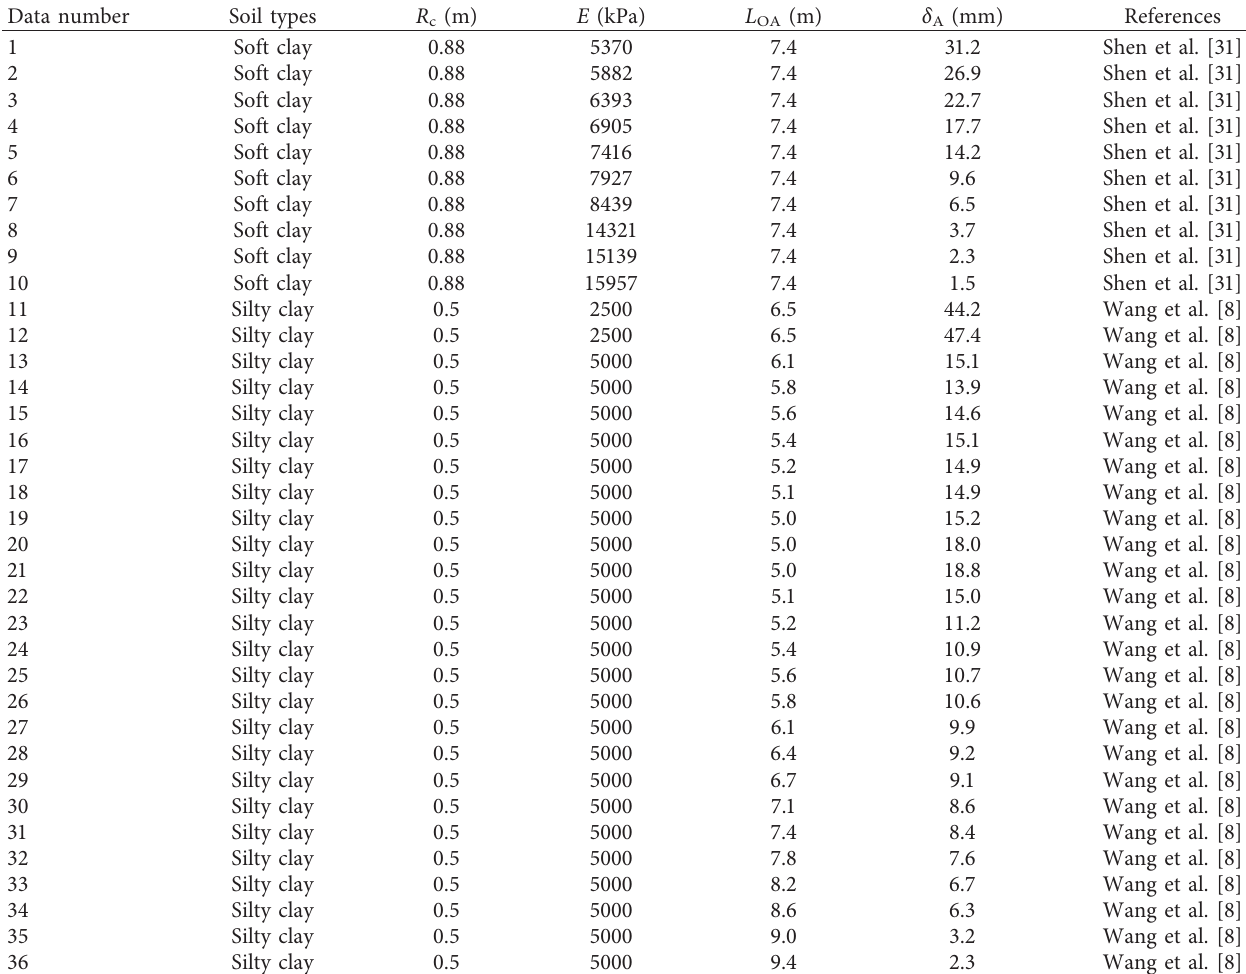
Figure 1: Schematic view of ground displacements caused by installing a jet grouted Table 1: Data collected in this study.